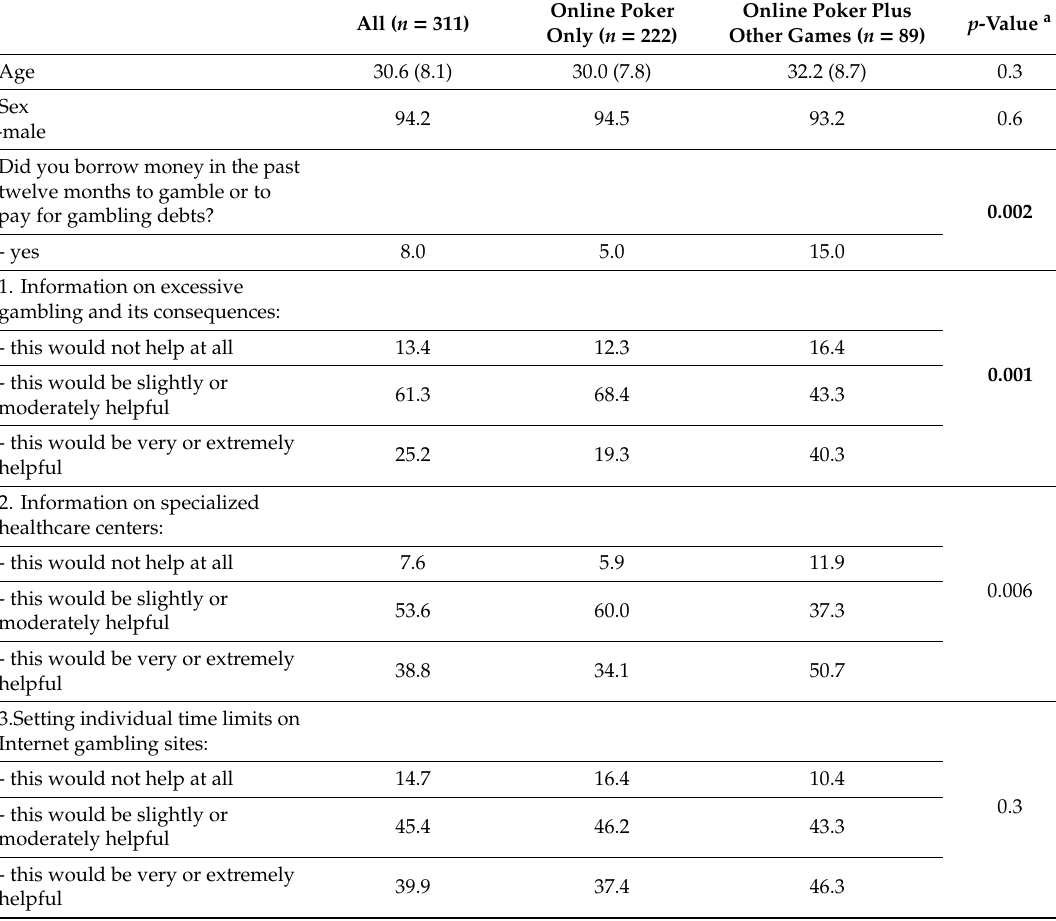
Table 2. Harm reduction items by game type. Data are expressed as mean ( ± SD) or